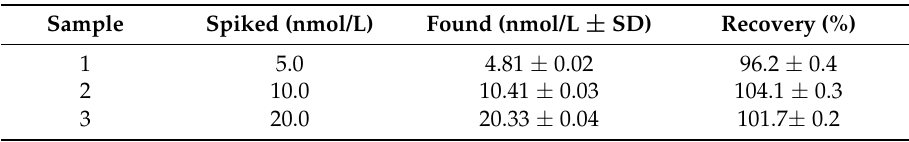
Table 2. Detection of actual samples ( n = 6).